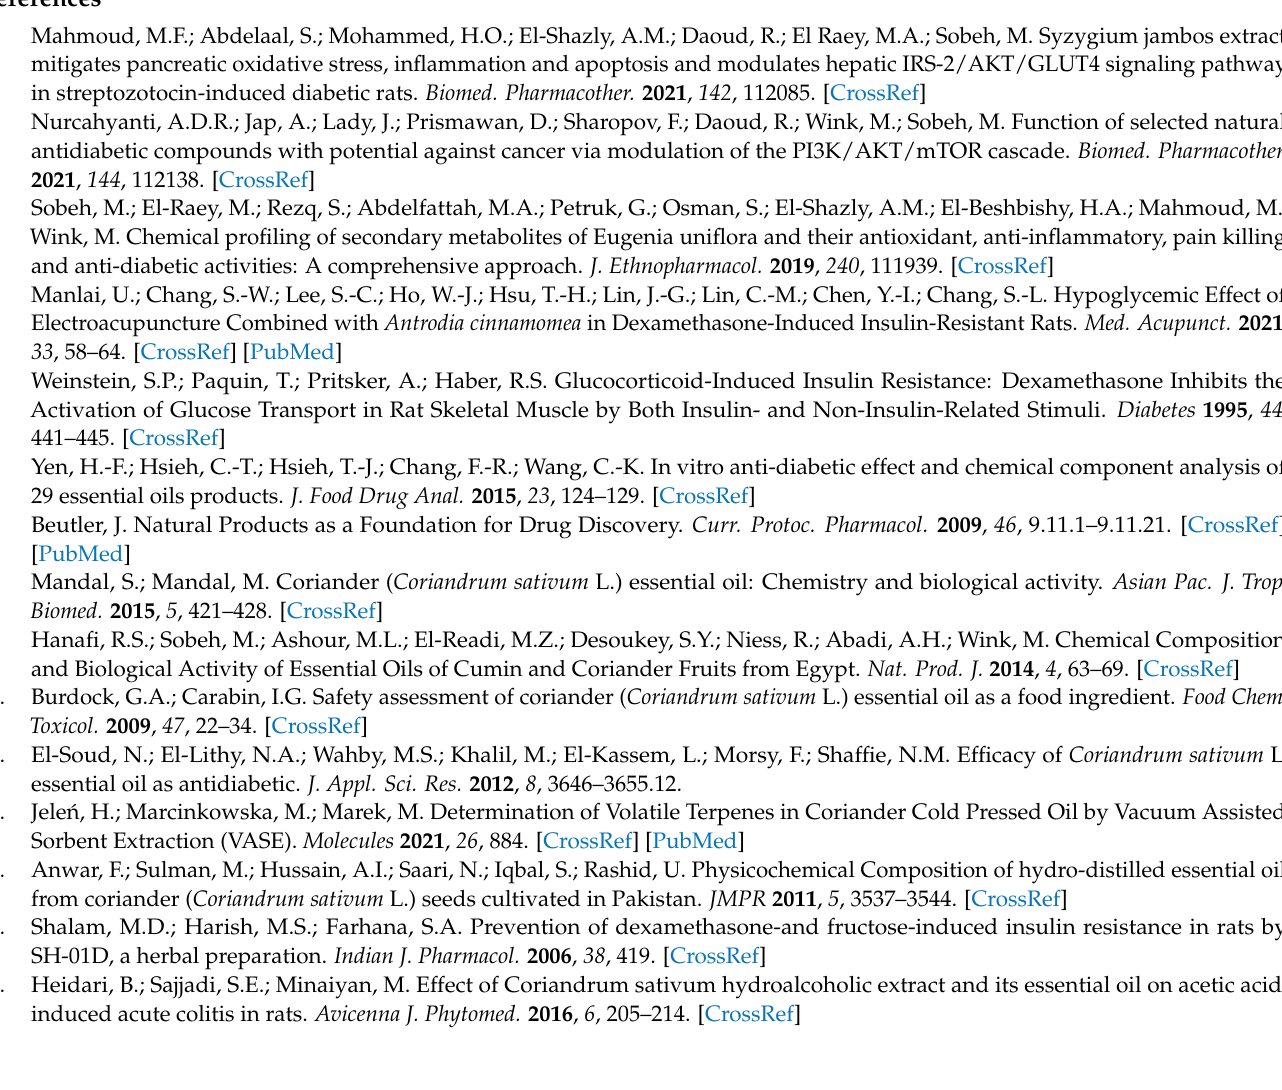
oil. Table S1: Essential oil composition of C. sativum fruits using GC-MS